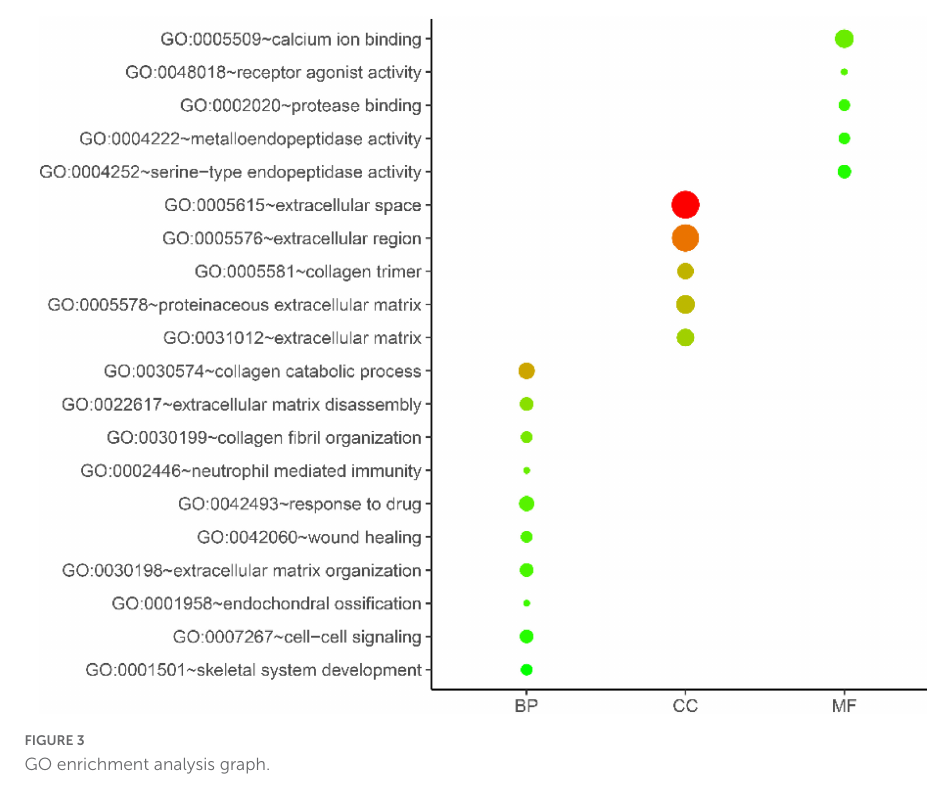
FIGURE3 GO enrichment analysis graph.